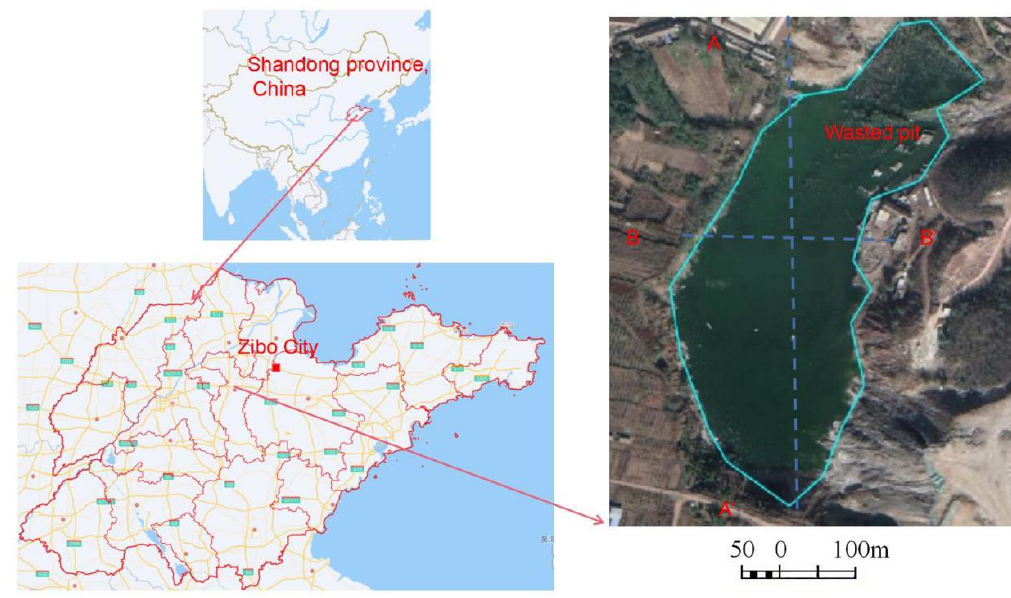
Figure 1. Map of wasted pit in the study area.